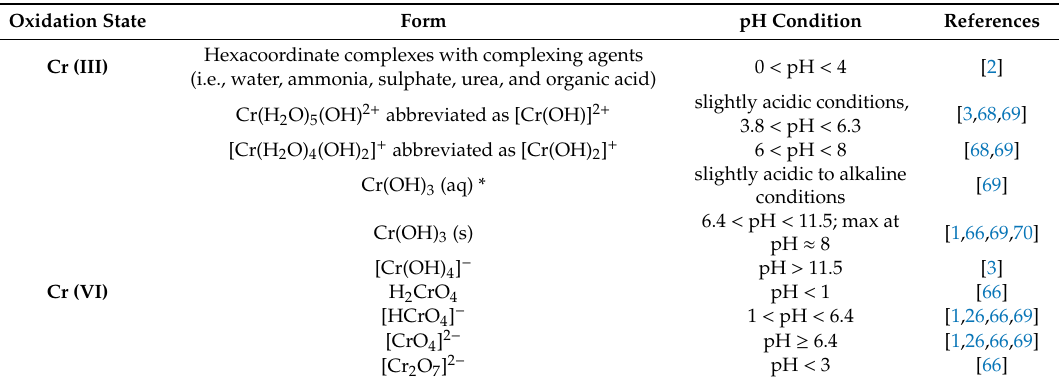
Table 2. Chromium oxidation states and main forms in aquatic